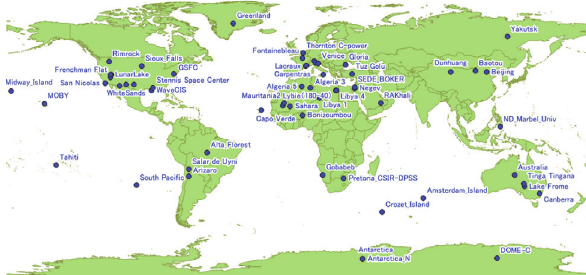
Figure 5. Candidate of radiometric calibration sites in the